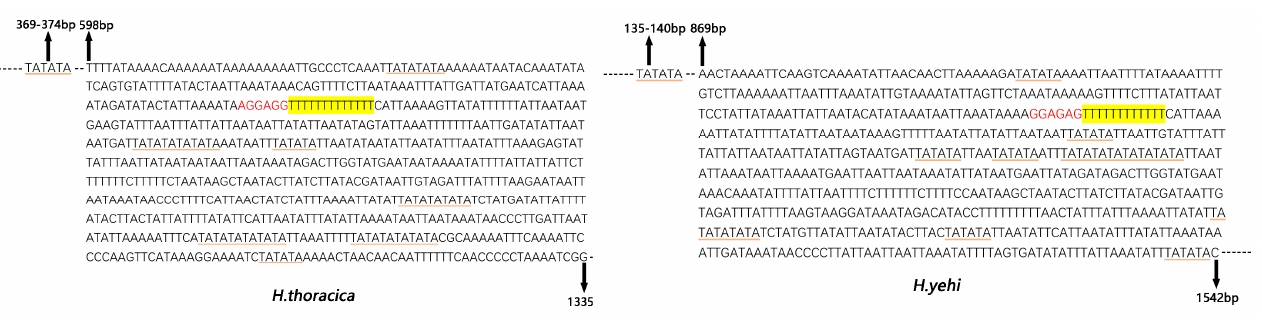
Figure 9. Features present in the control region of H. thoracica (left) and H. yehi (right).